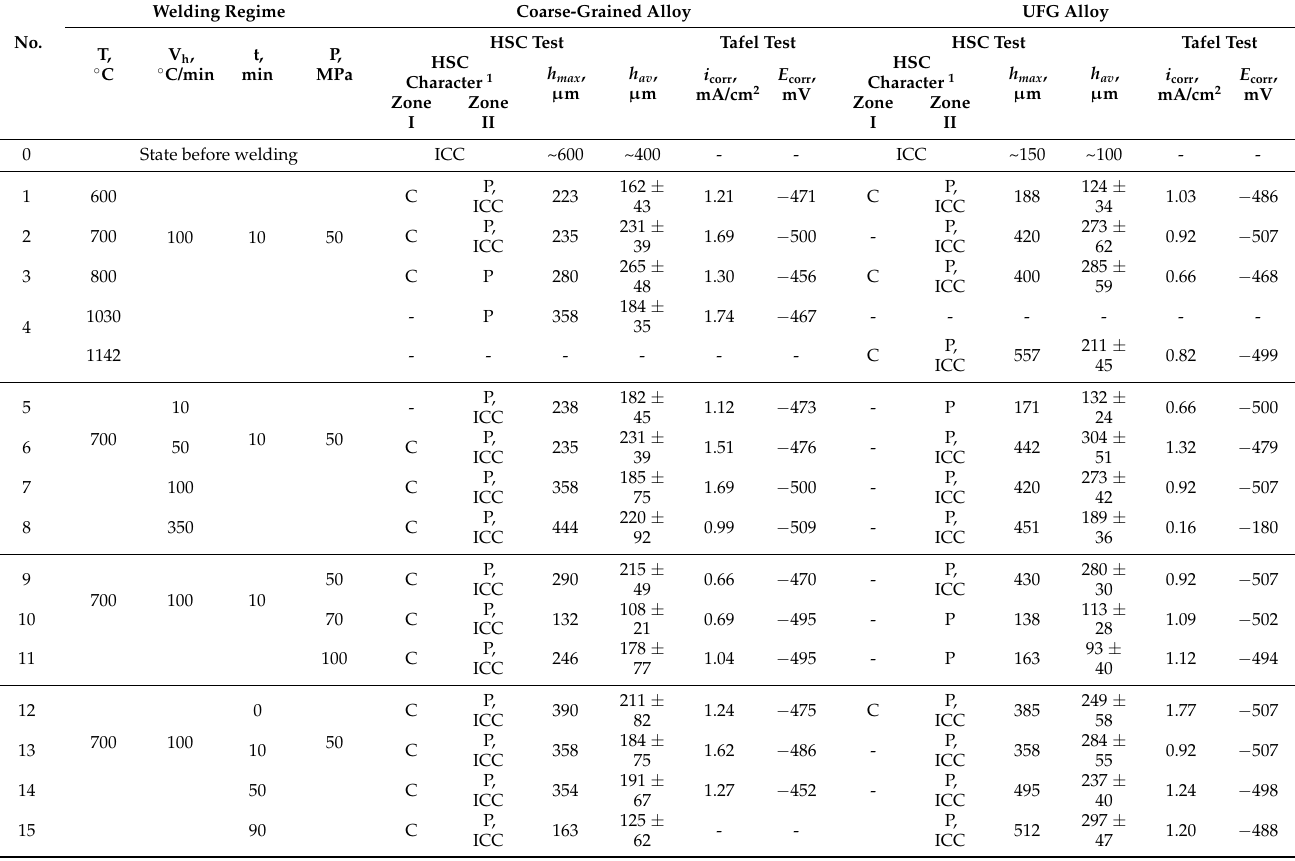
Table 3. Results of the corrosion testing of the welded joints of the PT-3V